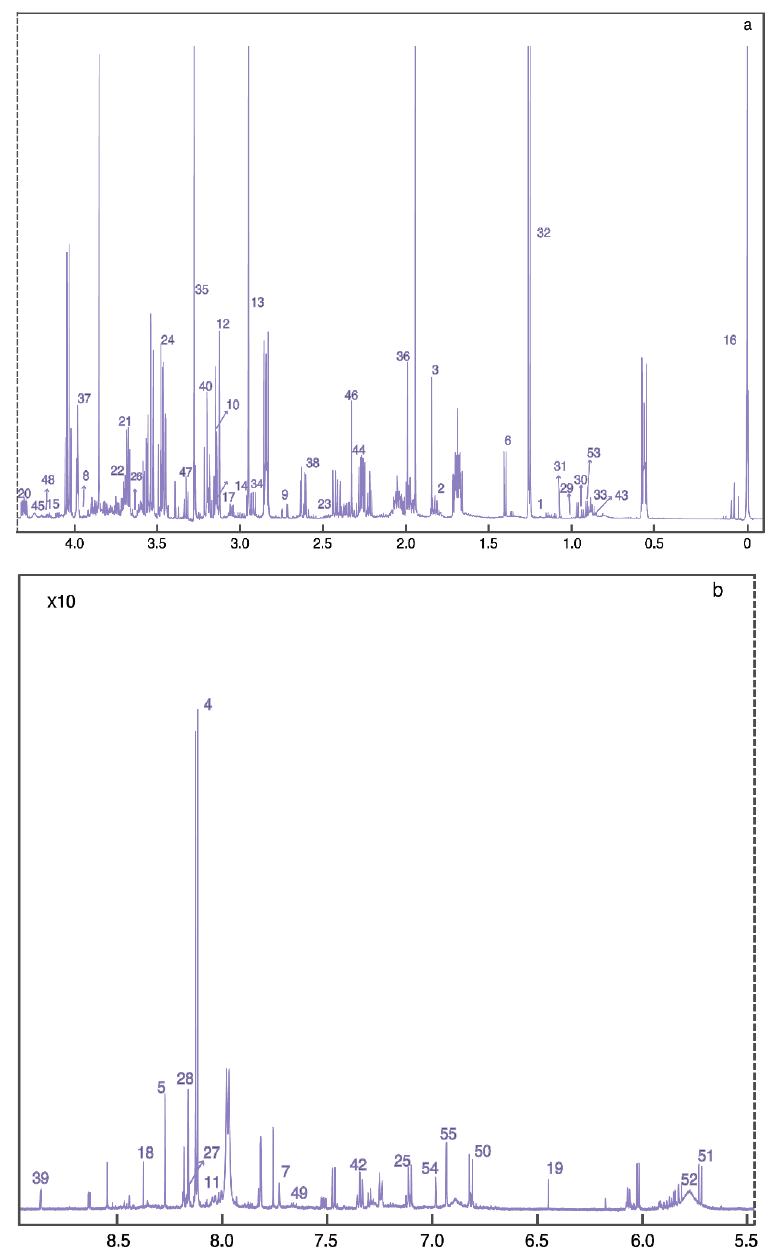
Table S1 in the Supplementary Materials.